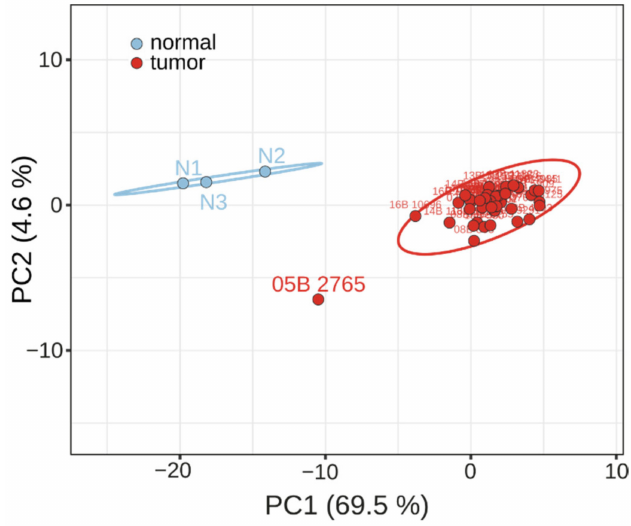
Figure 3. PCA analysis of RNA expression. Dots indicate OSCA tissue samples (red) and normal ovary tissue samples (blu). X and Y axis show principal component 1 (PC1) and principal component 2 (PC2), which explain 69.5% and 4.6% of the total variance, respectively. Ellipses indicate that a new sample from the same tissue type will fall inside the ellipse with a probability